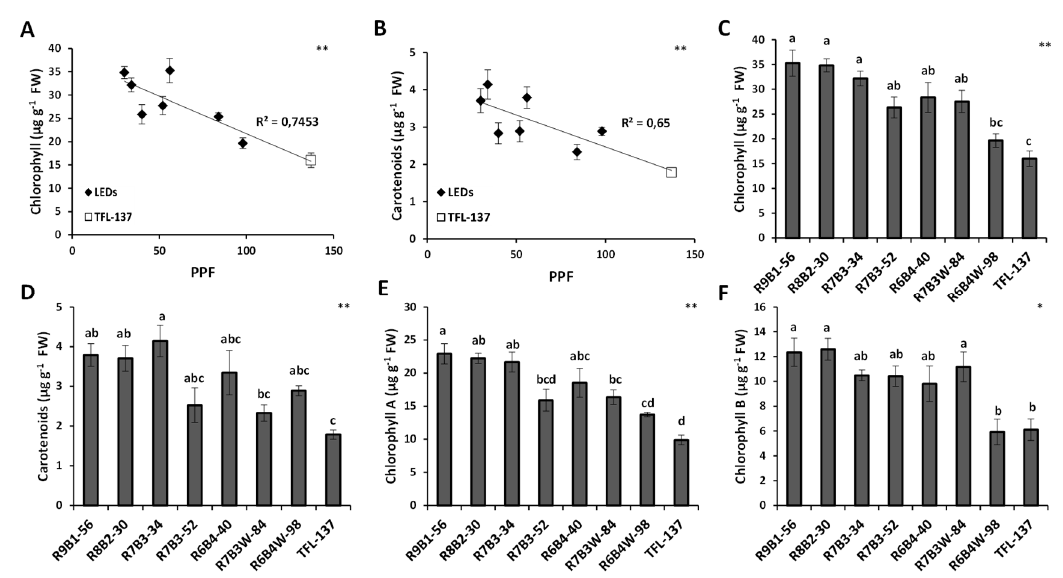
Figure 6. Effect of illumination quality and quantity on pigment composition. Correlation between light intensity and total chlorophylls ( A ) or carotenoid pigments ( B ) of micropropagated AMK34 plant leaves. Effects of different illumination regimes from light-emitting diodes (LEDs) and fluorescent lighting (TFL-137) on: total chlorophylls ( C ) and carotenoid pigments ( D ) in micropropagated shoots of AMK34 plants. Effects of different illumination regimes from light-emitting diodes (LEDs) and fluorescent lighting (TFL-137) on: chlorophyll-A ( E ) and chlorophyll-B ( F ). PPF, photosynthetic photon flux. Levels of significance: * p ≤ 0.05; ** p ≤